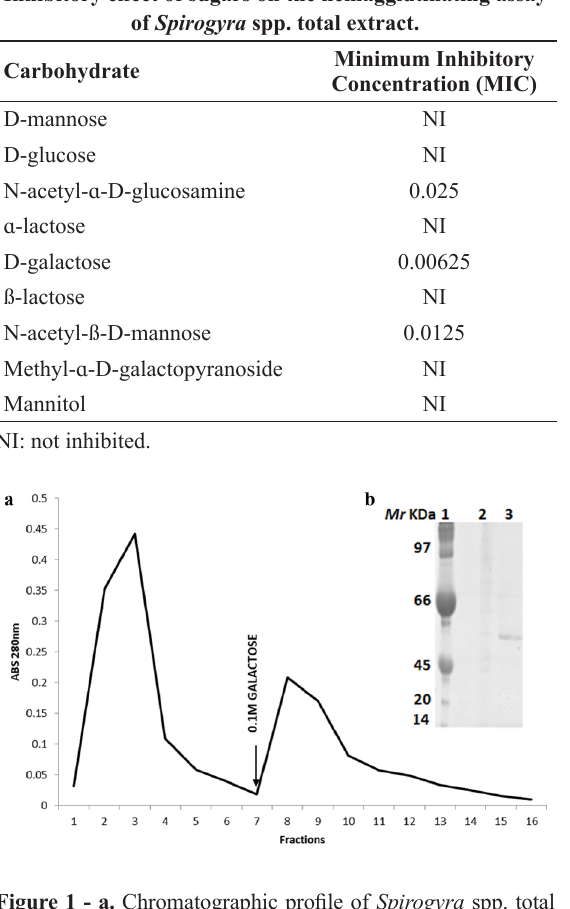
Figure 1 - a. Chromatographic profile of Spirogyra spp. total extract applied in guar gum column; PI eluted with 0.1 M Tris- HCl pH 7.6 with 0.15 M NaCl; PII eluted with 0.1 M galactose with 0.15M NaCl. b. 12% Polyacrylamide gel electrophoresis in the presence of sodium dodecyl sulfate (SDS-PAGE). Well 1: Molecular markers (phosphorylase b, 97 kDa; bovine serum albumin, 66 kDa; ovalbumin, 45 kD; trypsin inhibitor 20.1 kDa and α -lactalbumin 14.4 kDa). Well 2: Total extract. Well 3: Guar gum